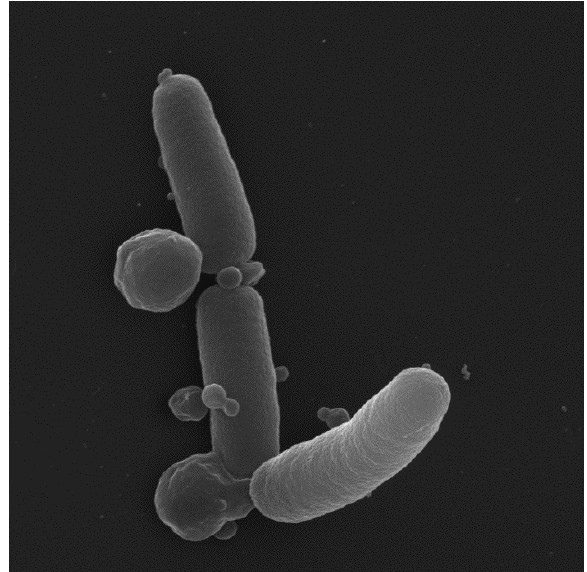
FIGURE 1: SEM image of E. coli undergoing ObgE*-mediated PCD. Expression of ObgE* causes the extensive formation of membrane